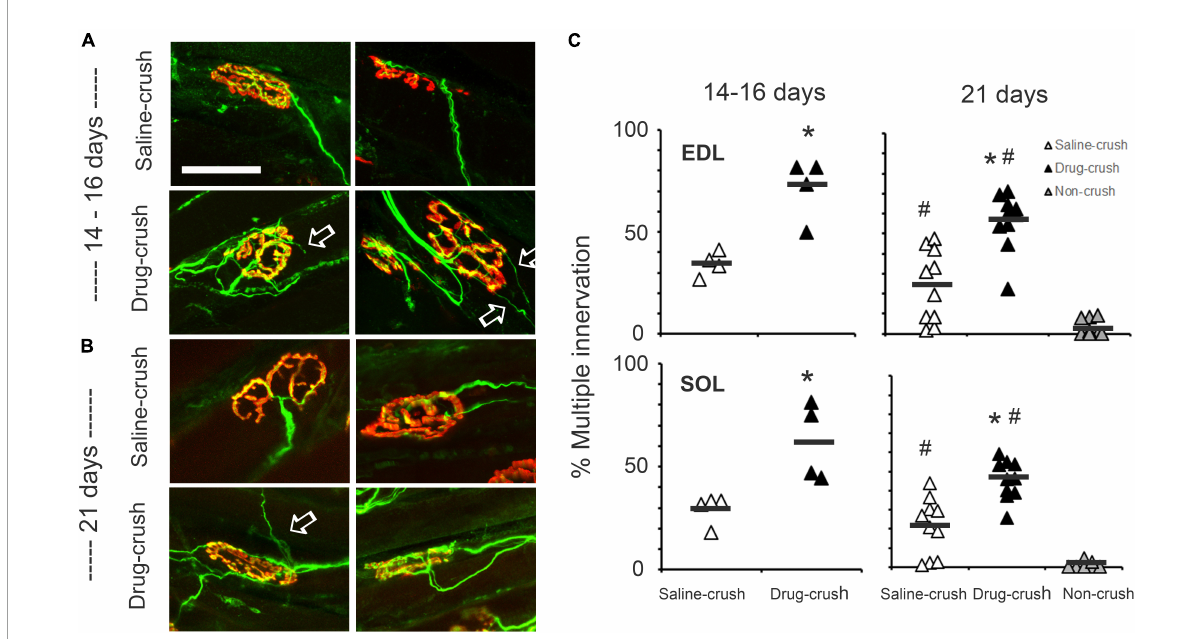
FIGURE3 Elimination of polyneuronal innervation. (A) Examples of neuromuscular innervation in extensor digitorum longus (EDL) muscles at 14–16 days post-crush. Red: acetylcholine receptors at NMJ; green: regenerated sciatic nerve axons. The top row shows images from muscles treated with saline-impregnated Elvax (saline-crush), while the bottom row shows images from muscles treated with AP5&CNQX-impregnated Elvax (saline-crush). White arrows indicate examples of axon branches that extend beyond the endplate. (B) Neuromuscular junctions in EDL muscles at 21 days post-crush from muscles treated with saline-impregnated Elvax (saline-crush, top) or AP5&CNQX-impregnated Elvax (saline-crush, bottom). (C) Percentages of muscles with multiple innervation. Each symbol represents counts from a single muscle. Data from the EDL muscles at 14–16 or 21 days post-crush are illustrated in the upper row, while data from the soleus muscle are shown below. Open triangles: saline treatment; black triangles: AP5&CNQX-treated muscles. The extreme right columns in the 21-day charts also show the percentages of multiply-innervated axons from control muscles with no nerve crush (non-crush, gray triangles). Asterisks indicate difference from saline-crush; hashtags indicate difference at 21 days from non-crush control, p < 0.05, two-way t -test or one-way ANOVA Tukey post-hoc test. n = 4 for saline and drug-crush at 14–16 days. n = 10 for saline and drug-crush and 6 for non-crush at 21 days. Scale bar = 50 µ m. # Indicate difference at 21 days from non-crush